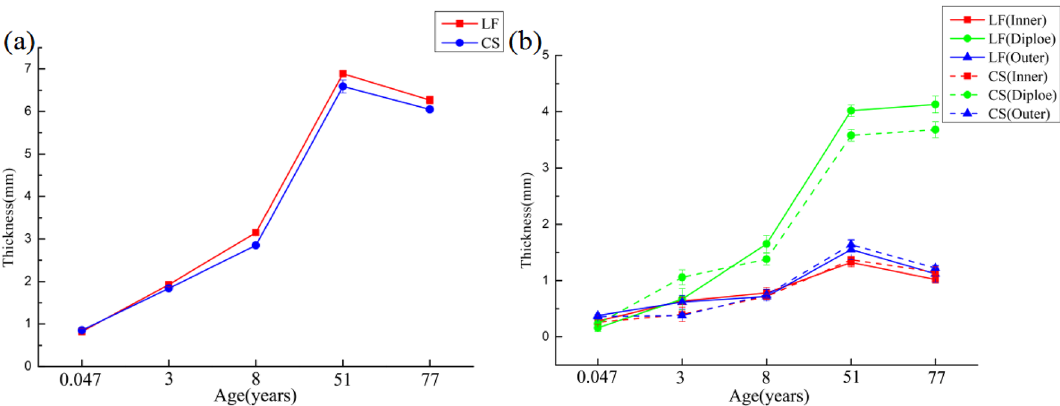
Figure 4. Change trend diagram of thickness of total and different layers of LF and CS at different ages. The ( a ) is the thickness of the whole skull, and ( b ) is the thickness of each layer of the skull inner plate, the diploe and the outer plate.